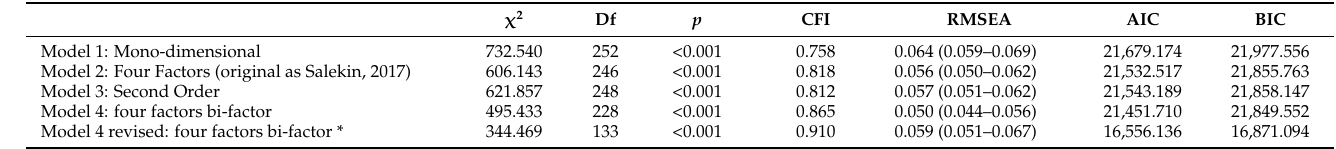
Table 2. Fit indices of the competing models.